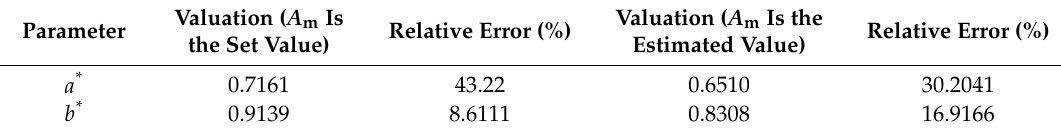
Table 2. Identification and errors of envelope parameters of the oblique envelope signal.